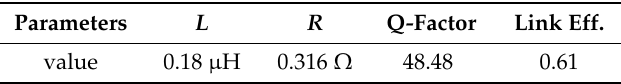
Table 2. Parameters and performance of the receiving